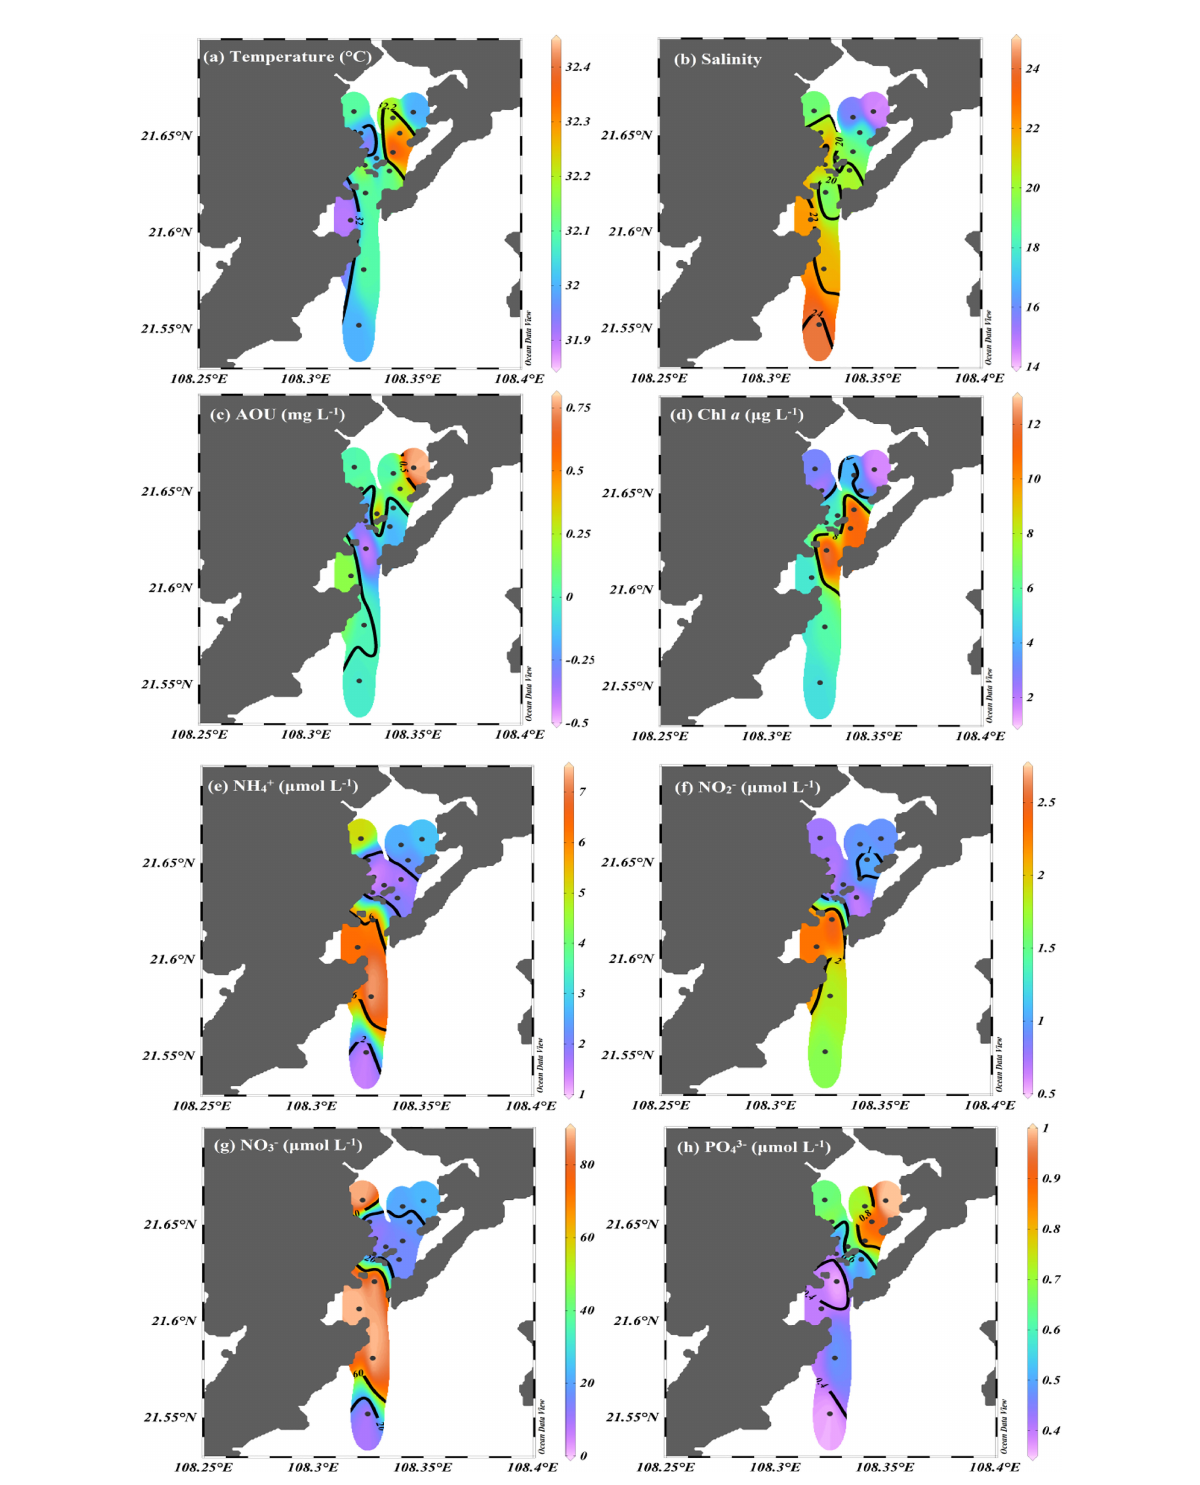
FIGURE 2 Spatial distributions of (A) temperature, (B) salinity, (C) AOU, (D) Chl a , and (E – H) nutrients (NH 4+ , NO 2 − , NO 3 − , PO 43 − ) in Xi Bay. Black dots represent the sampling